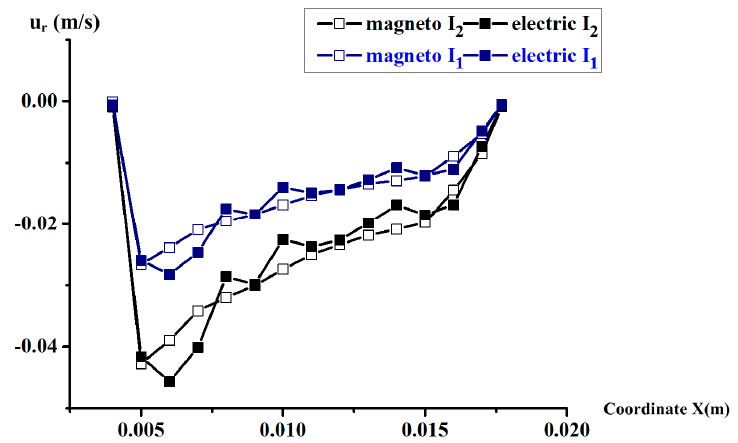
Figure 8. The radial velocity along the axis x, respectively, on the plane z = − 0.001 m using the electric and magnetic method under energized current I 1 = 1.5 A and I 2 = 3 A.